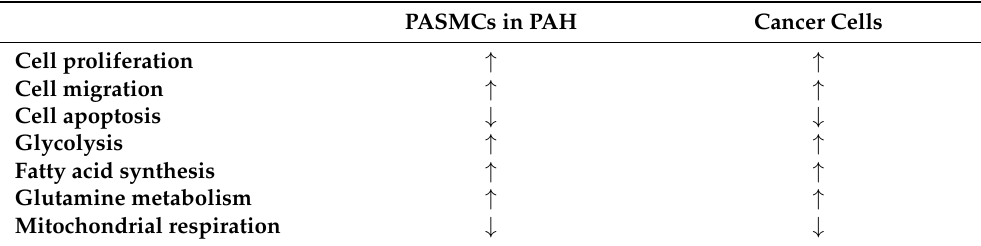
Table 1. Similarities between PASMCs in PAH pathogenesis and cancer